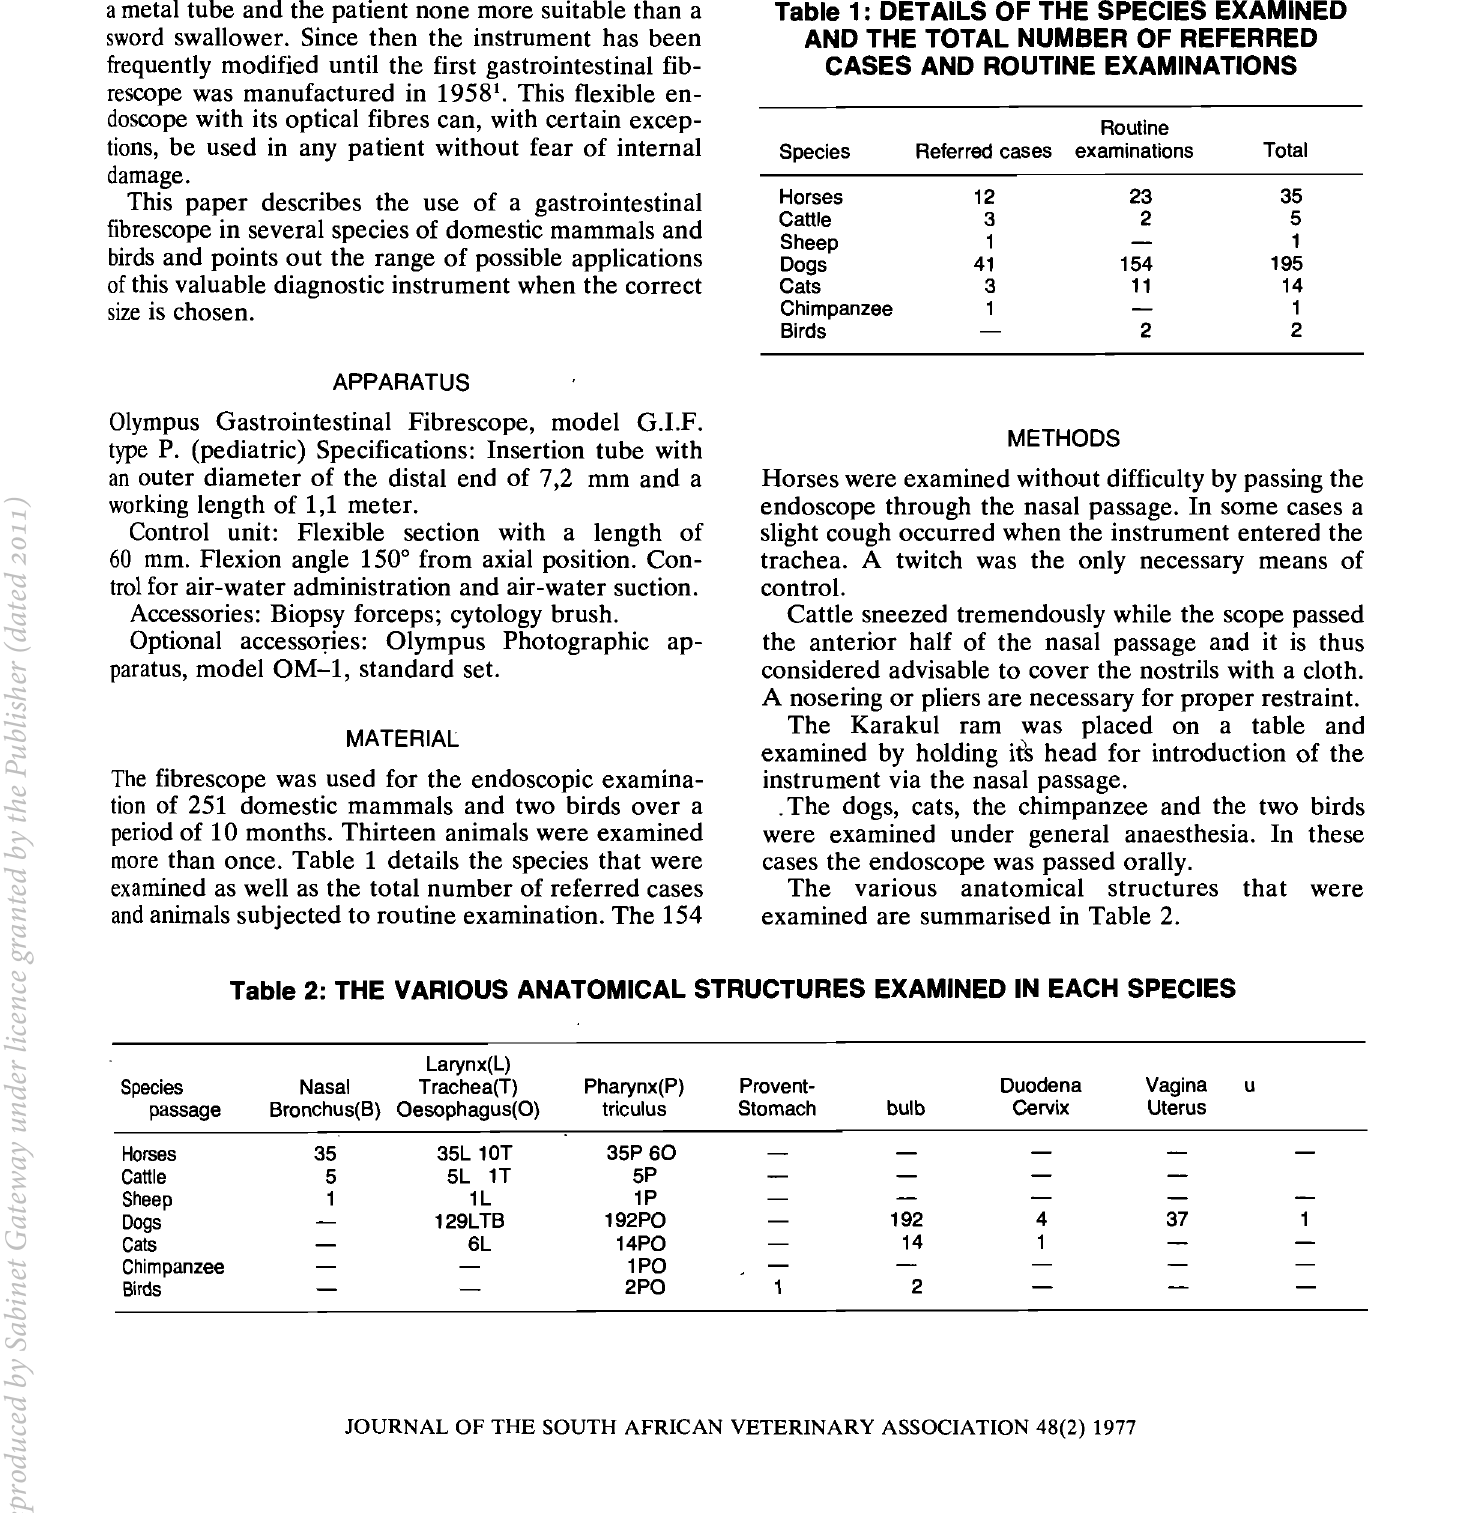
Table 1: DETAILS OF THE SPECIES EXAMINED